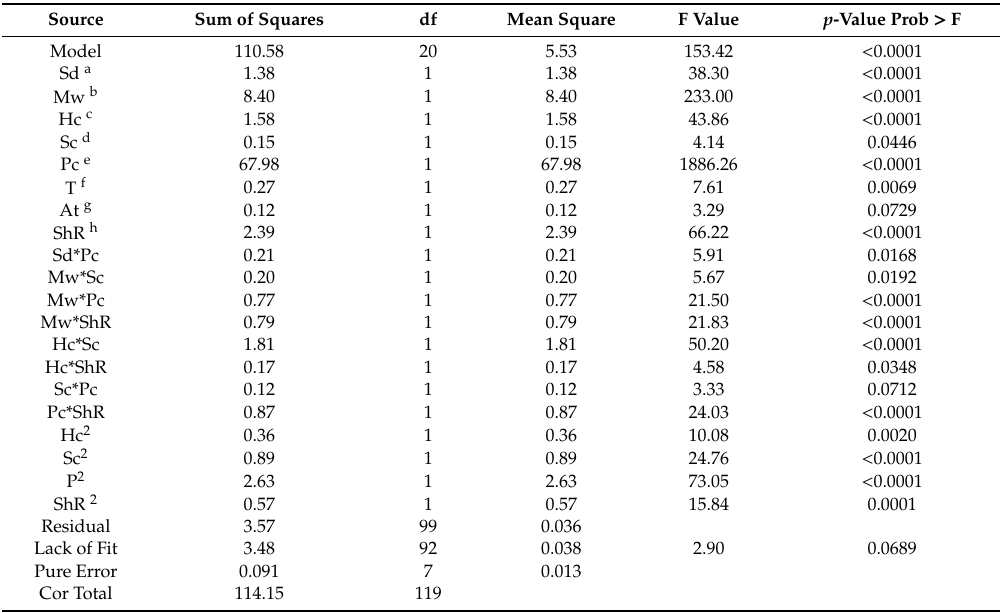
Table 4. ANOVA for response surface reduced quadratic model (viscosity is the response and transformed using Equation